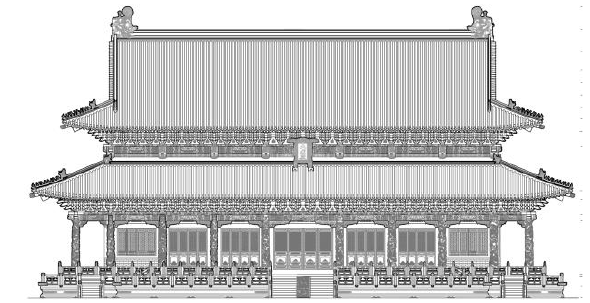
Figure 3. Front Elevation of the Hall of Great Achievements, Confucian Temple, Qufu, measured and drawn by Tianjin University